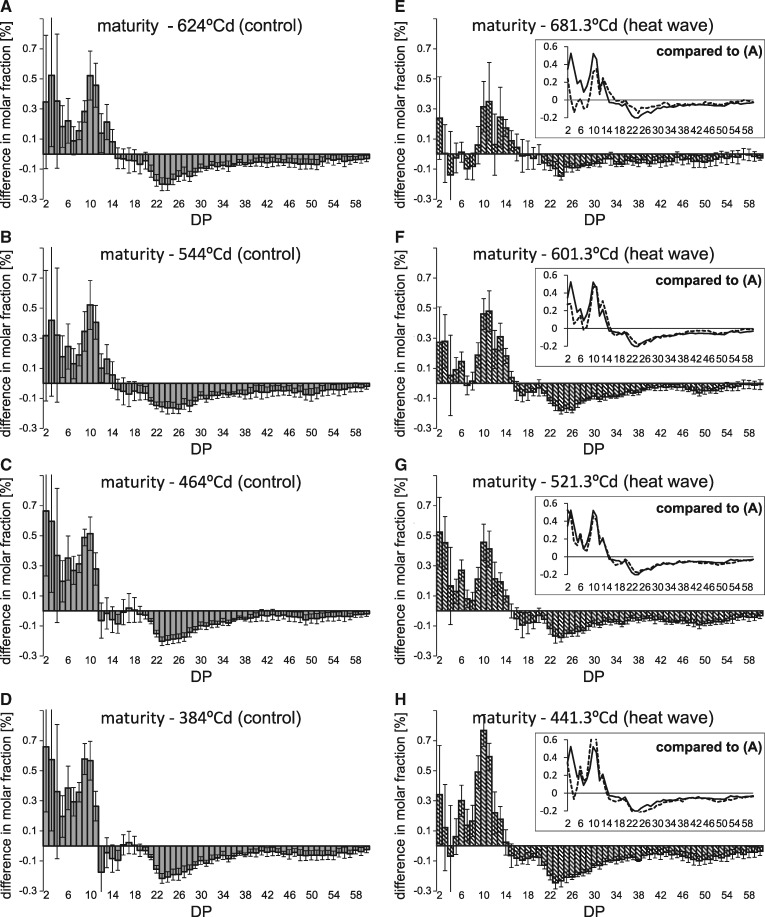
Changes in amylopectin structure during grain filling in comparison to maturity. Comparison of chain length distributions of debranched amylopectin between mature grains and developing grains from plants grown under control and heat wave conditions. Positive bars reflect an excess of those chains in mature grains. (A–D) The comparison between samples taken from mature plants and at 624, 544, 464 and 384�Cd for control conditions (filled bars). (E–H) The comparison between mature samples and those taken at 681, 601, 521 and 441�Cd from heat HT (striped bars). Inserts in (E–H) show a direct comparison between the respective chain length distribution to that in (A), where the solid line is the profile as in (A) and the dotted line is the profile as in the respective panel.